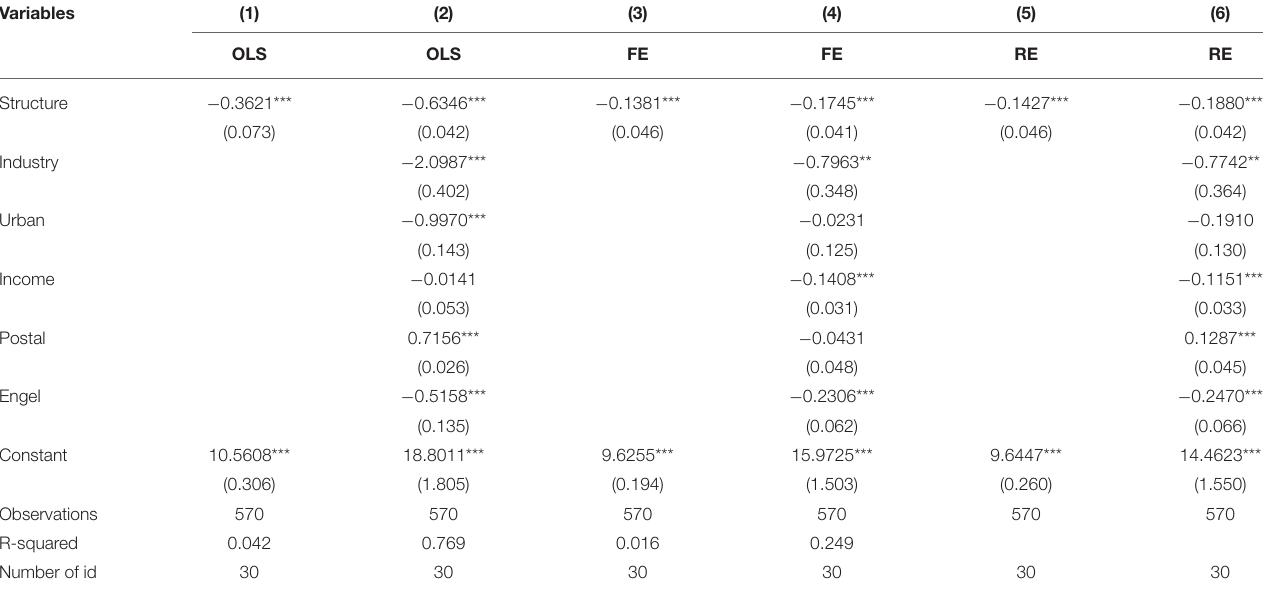
TABLE 6 | Benchmark regression result.